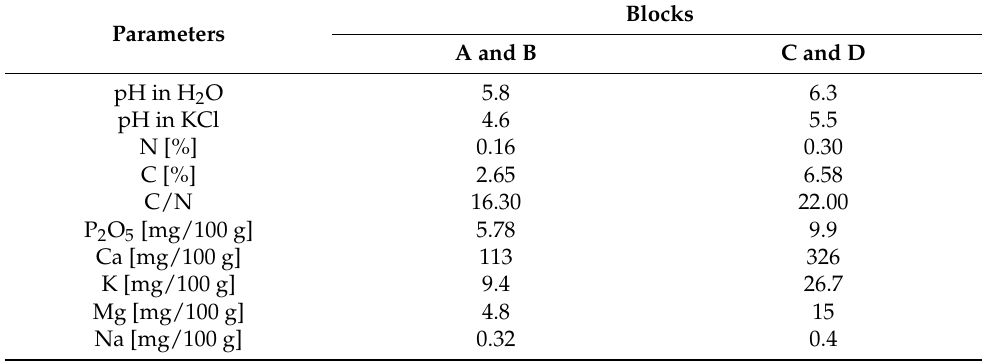
Table 3. Results of chemical analyses of